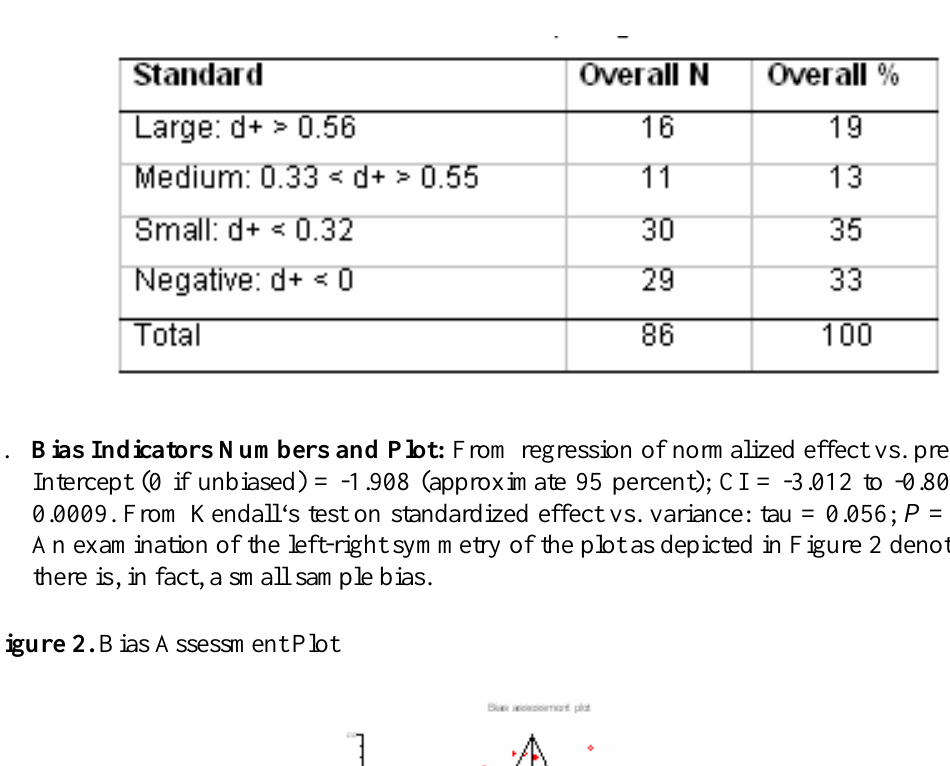
Table 1. Distribution of Effect Sizes by Magnitude